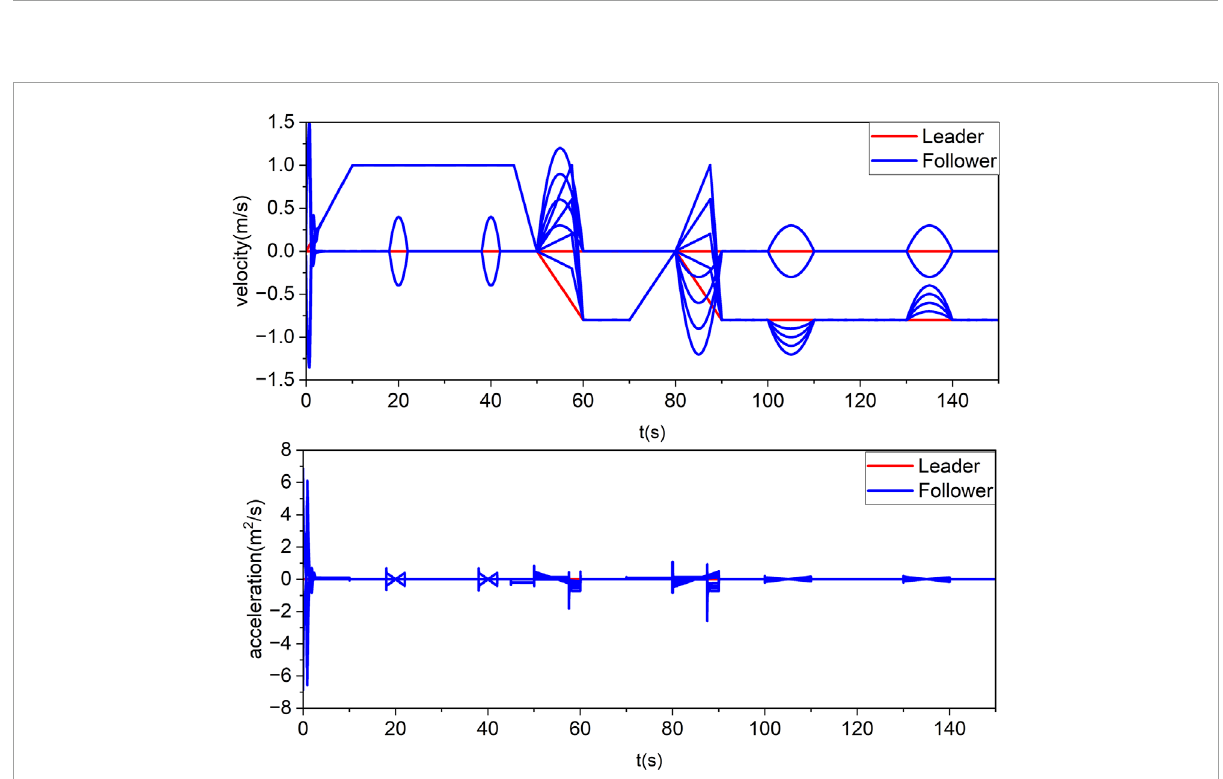
FIGURE 8 Velocity and acceleration of control law Eq. 17